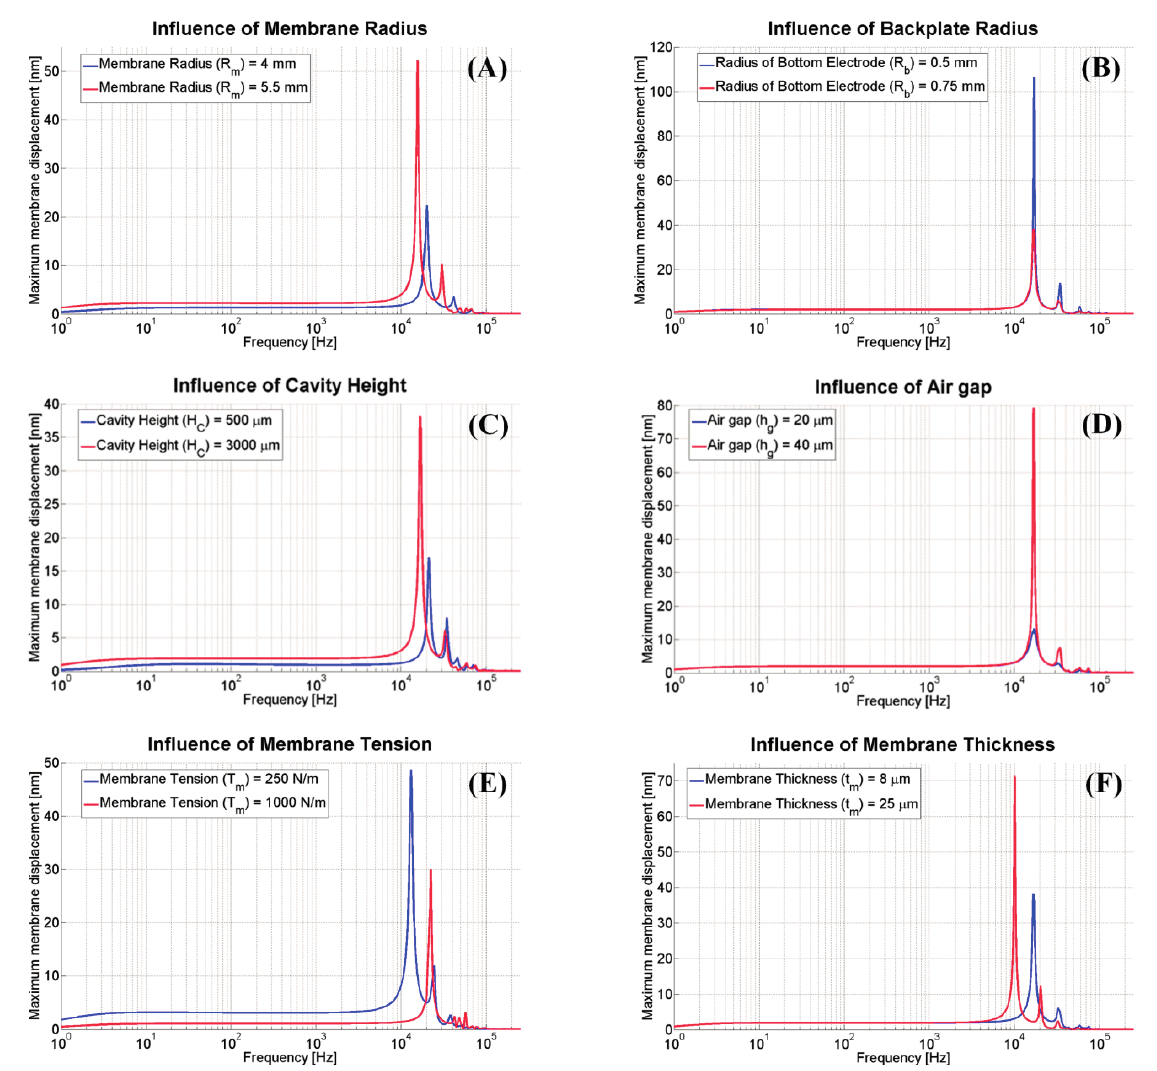
Figure 6. Effect of individual input parameter on the membrane displacement (other parameters kept at constant value: (cid:1844) = 500 N/m and (cid:1872) (cid:1846) (cid:3040)